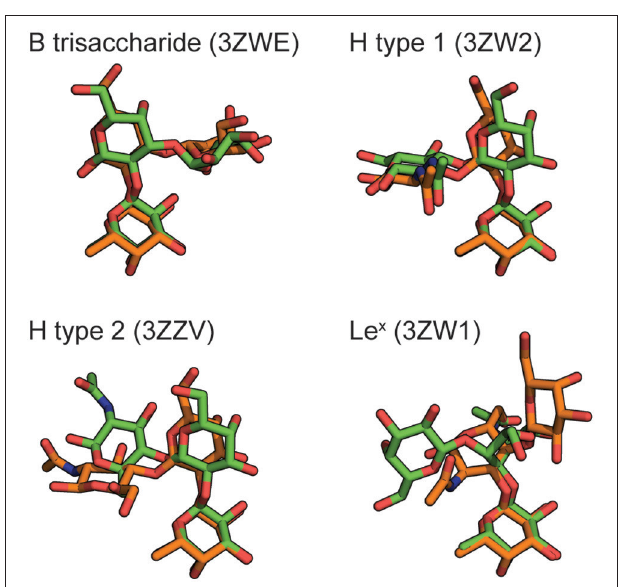
FIGURE 2 | Blood group carbohydrates docked into the BambL binding site of PDB ID: 3ZZV (orange), compared to their respective experimentally determined poses (green). The PDB IDs for experimental poses are indicated. For clarity, all carbohydrates are shown as the non-reducing-end trisaccharide without hydrogen